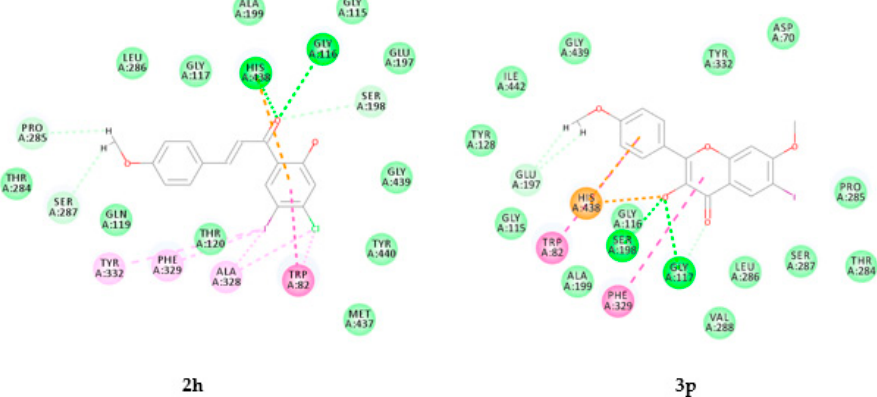
Figure 8. Docking poses of compounds 2h and 3P into the active site of BChE. Interactions are color coded, bright green represents conventional hydrogen bonds, light green ‐ van der Waals interactions, very light green ‐ carbon hydrogen bonds, orange ‐ pi carbon and attractive charge interactions, dark pink ‐ pi–pi interactions and light pink ‐ pi ‐ alkyl and alkyl interactions.